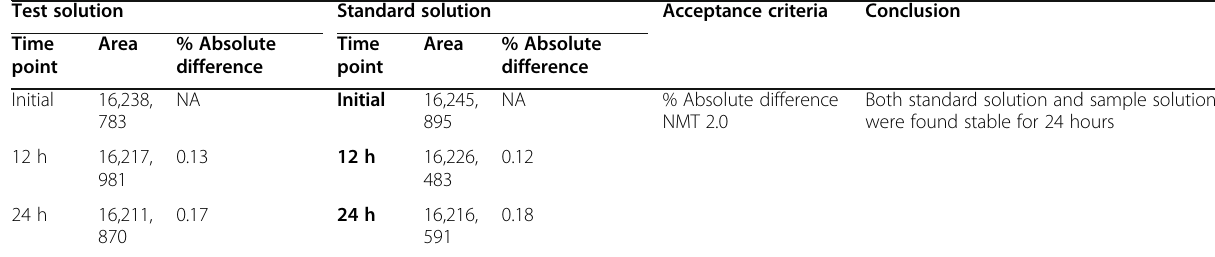
Table 9 Analytical data of brexpiprazole for solution stability